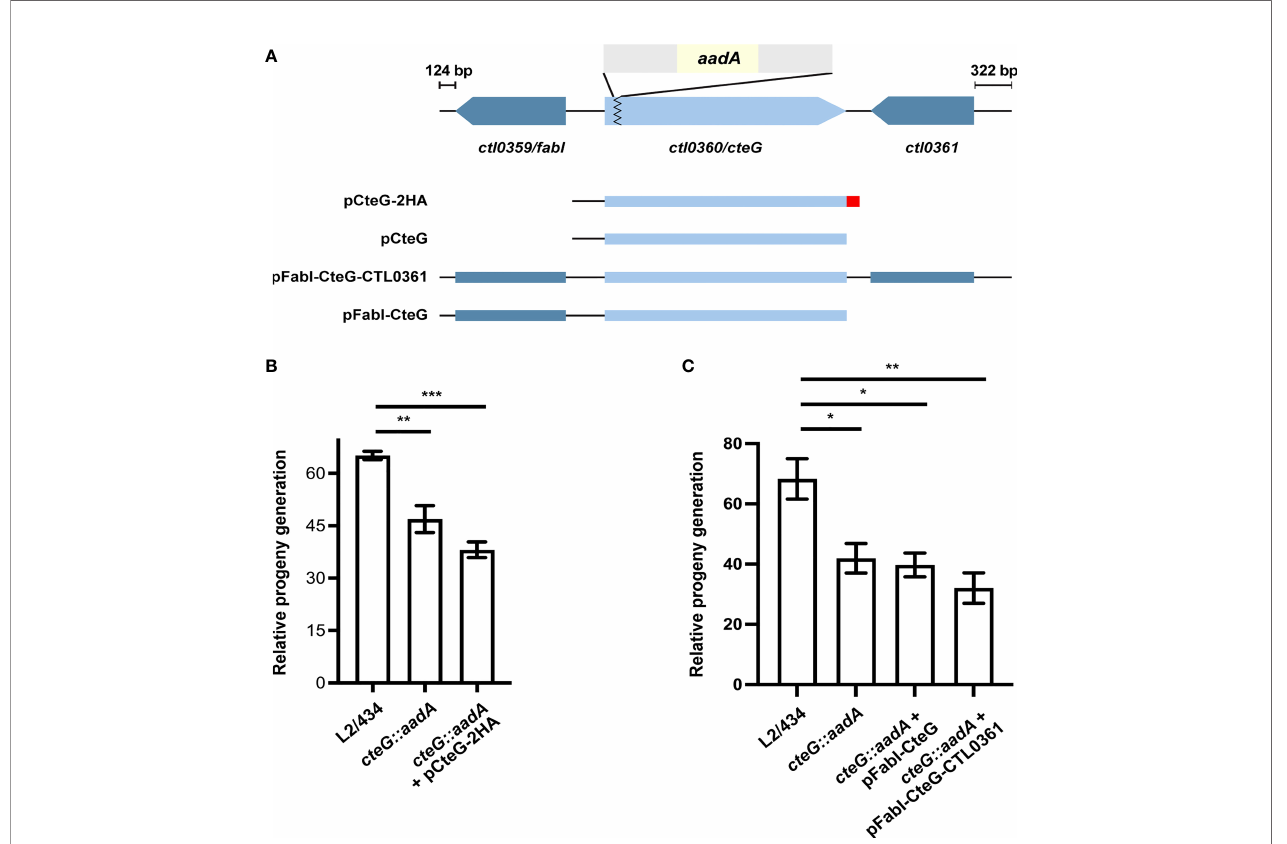
FIGURE 1 | A C. trachomatis cteG::aadA insertional mutant is defective in progeny generation. (A) Schematic representation of the genomic region of ctl0360 / cteG (light blue), which was disrupted by insertion of a modi fi ed group II intron (grey) carrying a spectinomycin-resistance gene, aadA (yellow) to generate a C. trachomatis cteG mutant strain ( cteG::aadA ) (Pais et al., 2019). The cteG::aadA mutant strain was transformed with plasmids encoding CteG fused to a double hemagglutinin tag (2HA; red; pCteG-2HA; also named pCteG-2HA[Pgp4 + ] in Table 1 and in Figures 4 , 5 ), native CteG (pCteG) ( Supplementary Figure S1 ), or CteG and two ( ctl0359/fabI and ctl0361 ; pFabI-CteG-CTL0361) or one ( ctl0359/fabI ; pFabI-CteG) of its fl anking genes (dark blue). (B) Two identical tissue culture plates seeded with HeLa cells were infected with C. trachomatis L2/434, cteG::aadA mutant and complemented ( cteG::aadA harboring a plasmid encoding CteG-2HA, also named pCteG-2HA[Pgp4 + ] in Table 1 and in Figures 4 , 5 ) strains at a MOI of 0.06. In one plate (input), the IFUs obtained in a primary infection were quanti fi ed at 24 h p.i. by immuno fl uorescence microscopy after fi xation and immunolabelling of the chlamydiae; in the second plate (output), cells were lysed at 40 h p.i. and the number of released infectious particles were quanti fi ed after infecting for 24 h a new plate seeded with HeLa cells followed by fi xation, immunolabelling of the chlamydiae, and immuno fl uorescence microscopy. For each strain, the relative progeny generation was obtained by dividing the number of IFUs in the output by those in the input. See Materials and Methods for a detailed description of the procedure. (C) cteG::aadA mutant strains harboring pFabI-CteG or pFabI-CteG-CTL0361 (see Panel A ) were assessed in terms of infectious progeny generation as in (B) by comparison with the parental (L2/434) and mutant ( cteG::aadA ) strains. Data in (B, C) correspond to the mean ± standard error of the mean (n=3). Statistical signi fi cance was determined by using ordinary one-way ANOVA and Dunnett post-test analysis relative to the L2/434 strain (*p<0.05; **p<0.01;